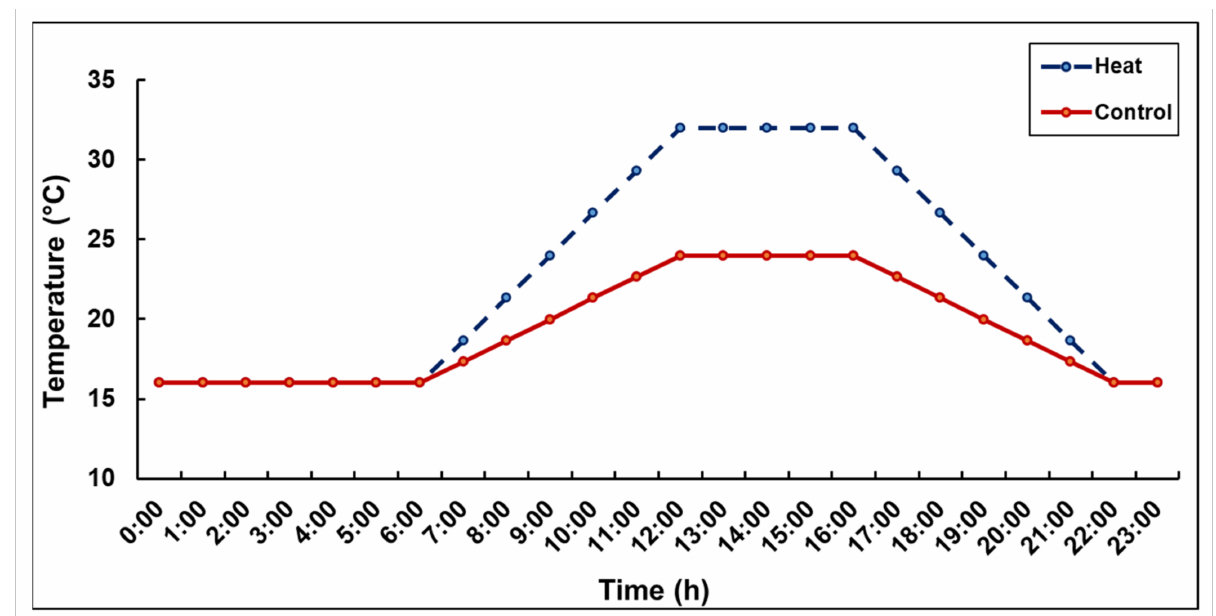
Figure 2. Diurnal temperatures in the controlled environment room (CER) during the 5 d temperature treatments. The control CER was set at 24/16 ◦ C (day/night), while the high temperature CER was set at 32/16 ◦ C (day/night). In the high temperature CER, temperature gradually increased from 16 ◦ C to 32 ◦ C from 06.00 h to 12:00 h (maximum temperature held from 12.00 to 16.00 h) and gradually decreased from 32 ◦ C to 16 ◦ C from 16:00 to 22.00 h. In the control CER, temperature was gradually increased from 16 ◦ C to 24 ◦ C from 06:00 to 10:00 h (maximum temperature held from 10:00 to 16:00 h) and decreased gradually from 24 ◦ C to 16 ◦ C from 16:00 to 22:00